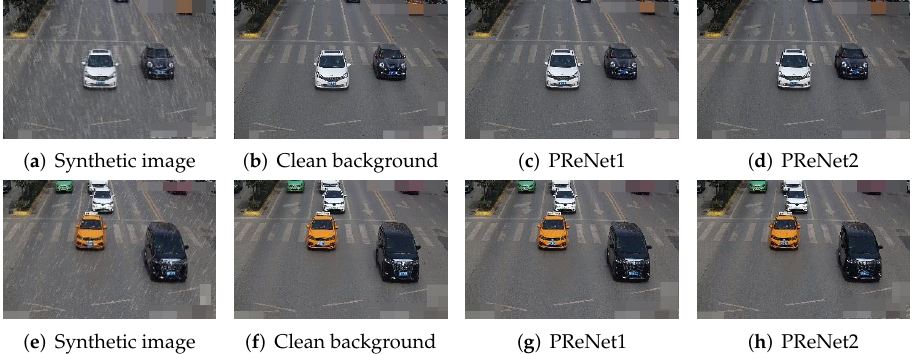
Figure 11. Test results on synthetic rain images from Rain Vehicle Color -24. PReNet 1 and PReNet 2 represent the different models, which are trained on the training subsets of Rain 100 L and Rain Vehicle Color -24,